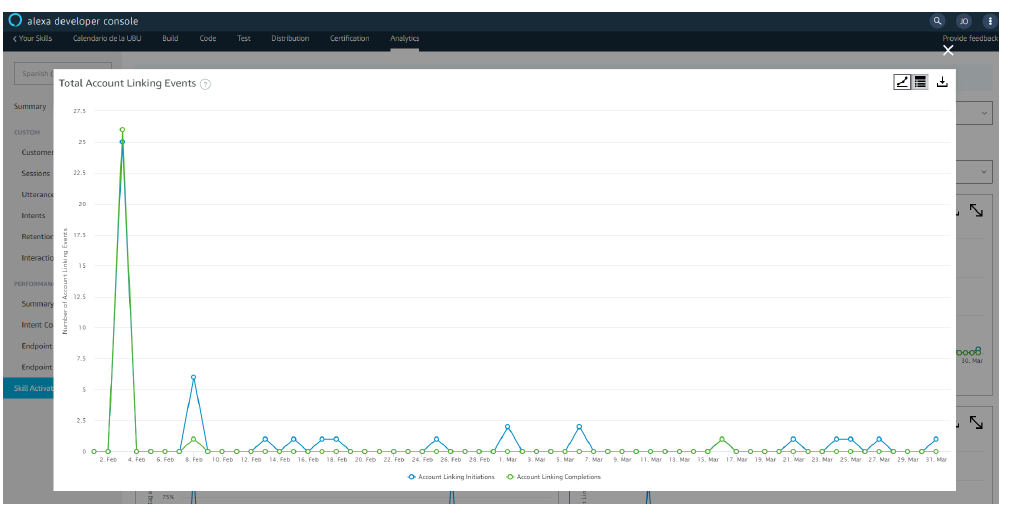
Figure 12. Account Linking data for Alexa